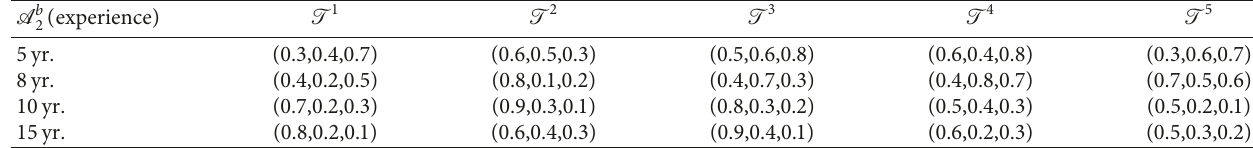
against experience. i